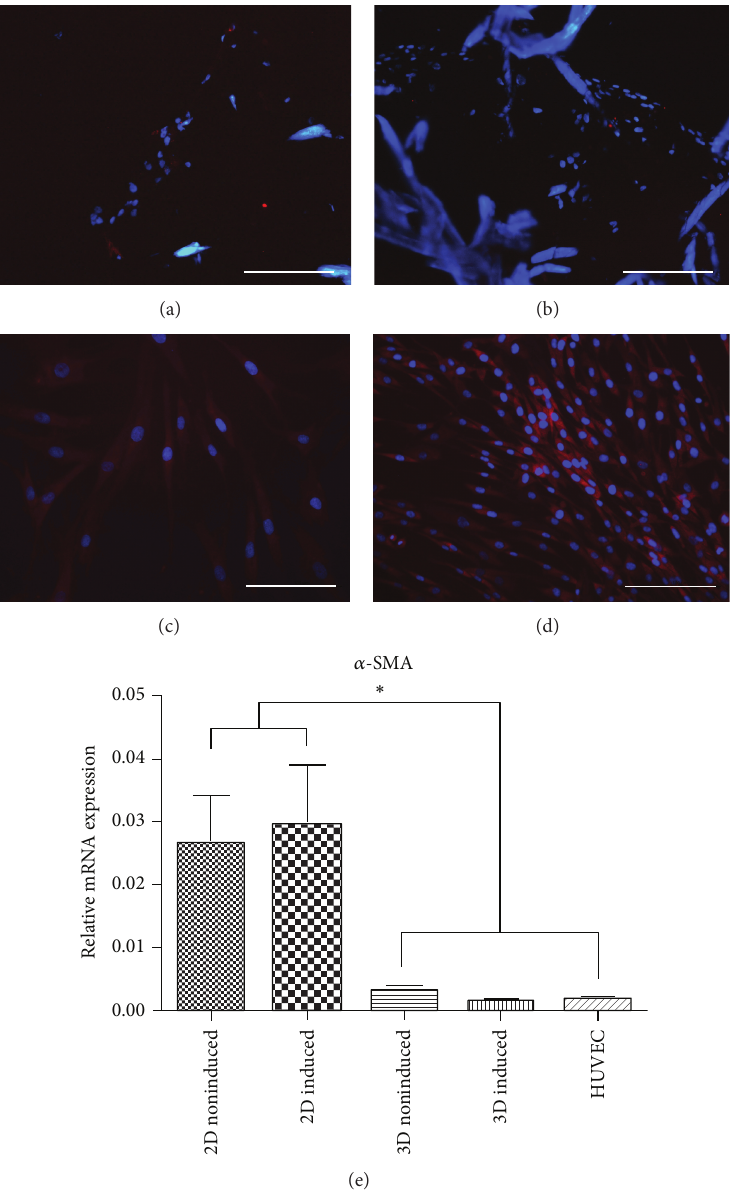
Figure 6: 𝛼 -SMA expression in 2D/3D cultured hADSCs. Immunofluorescence staining of 𝛼 -SMA in 3D noninduced (a), 3D induced (b), 2D noninduced (c), and 2D induced (d) groups after 7 days in vitro. mRNA expression of 𝛼 -SMA in these 4 groups and HUVEC after 7 days in vitro. ∗ 𝑃 < 0.05 (scale bars: 100 𝜇